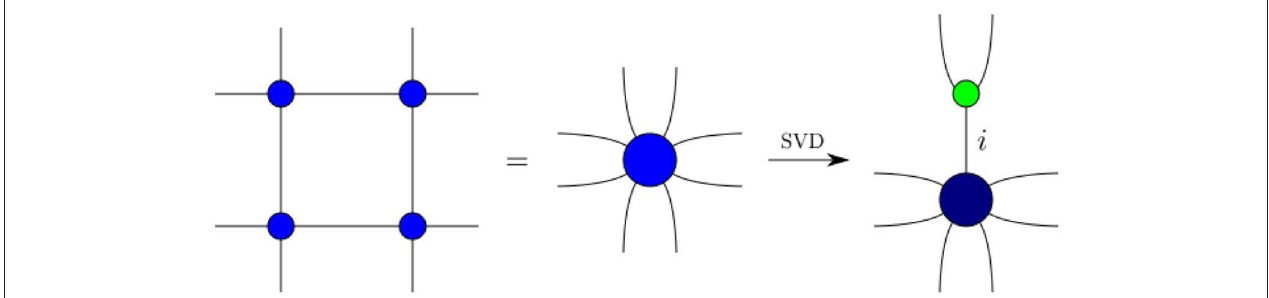
FIGURE 8 | The embedding maps are computed from the contracted tensor with multiple indices. It is split apart into two tensors, connected by a new effective edge labeled by the singular values indicating the relevance of the degree of freedom. The green, three-valent tensor then serves as an embedding/coarse graining map for the fine degrees of